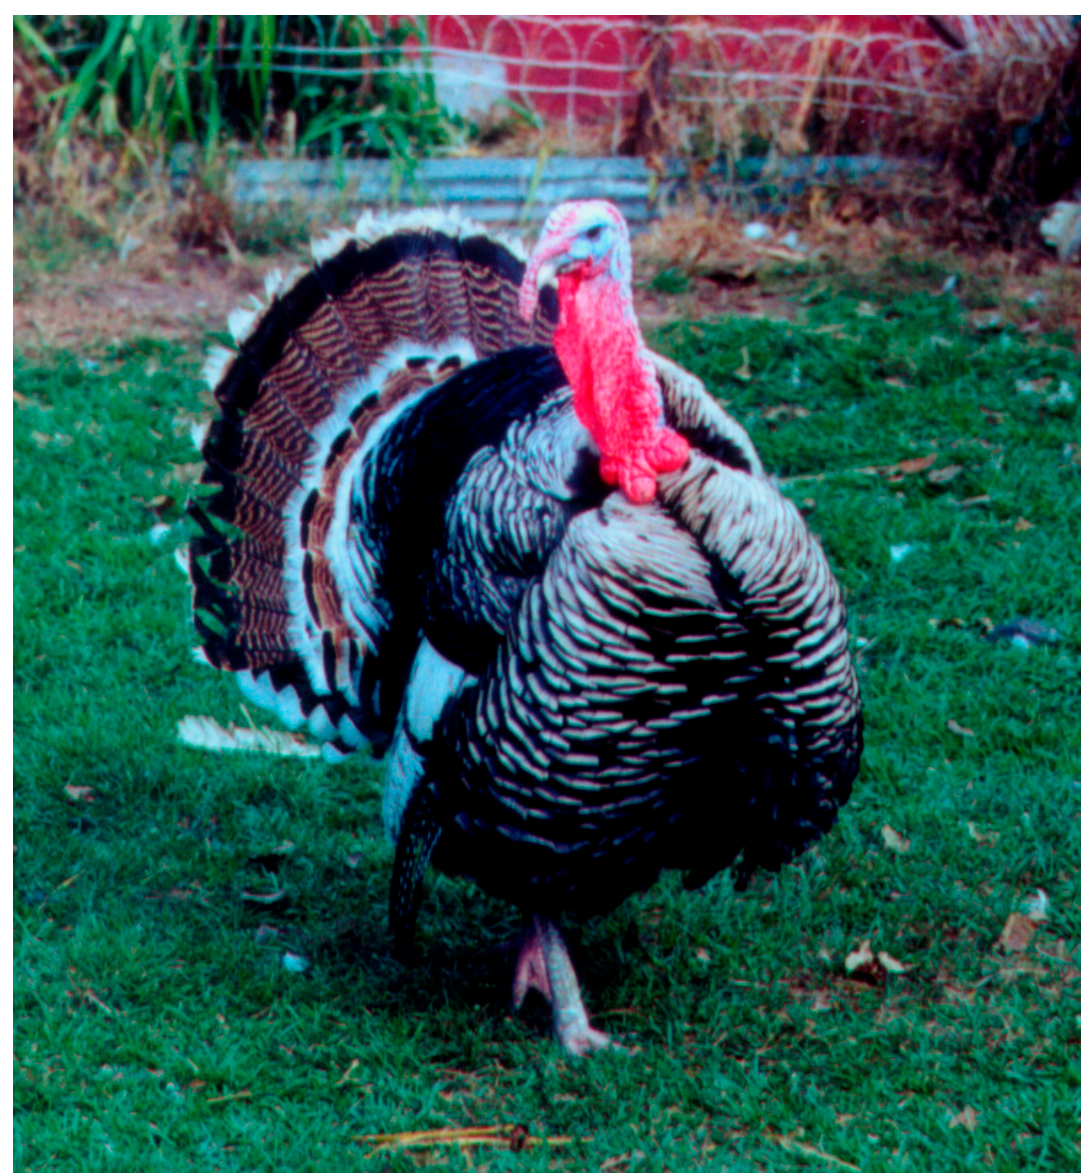
Figure 6. Heritage turkey of the Narragansett variety. Photo by D.P. Sponenberg.